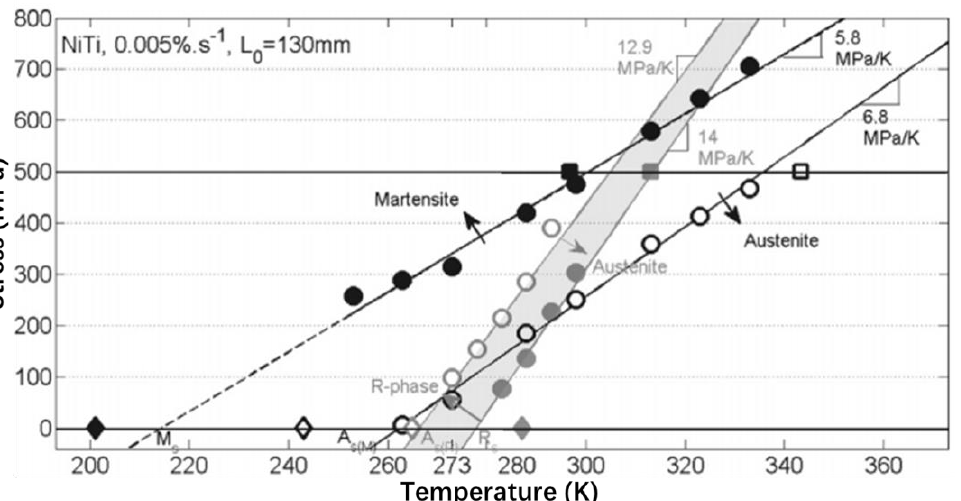
Figure 10. Pseudo-diagram of the studied NiTi alloy. The stress-temperature slope of R-phase is twice that of martensite phase. [39]. (Reprinted from Ref. [39], Figure 7, 2014, with permission from Elsevier.)